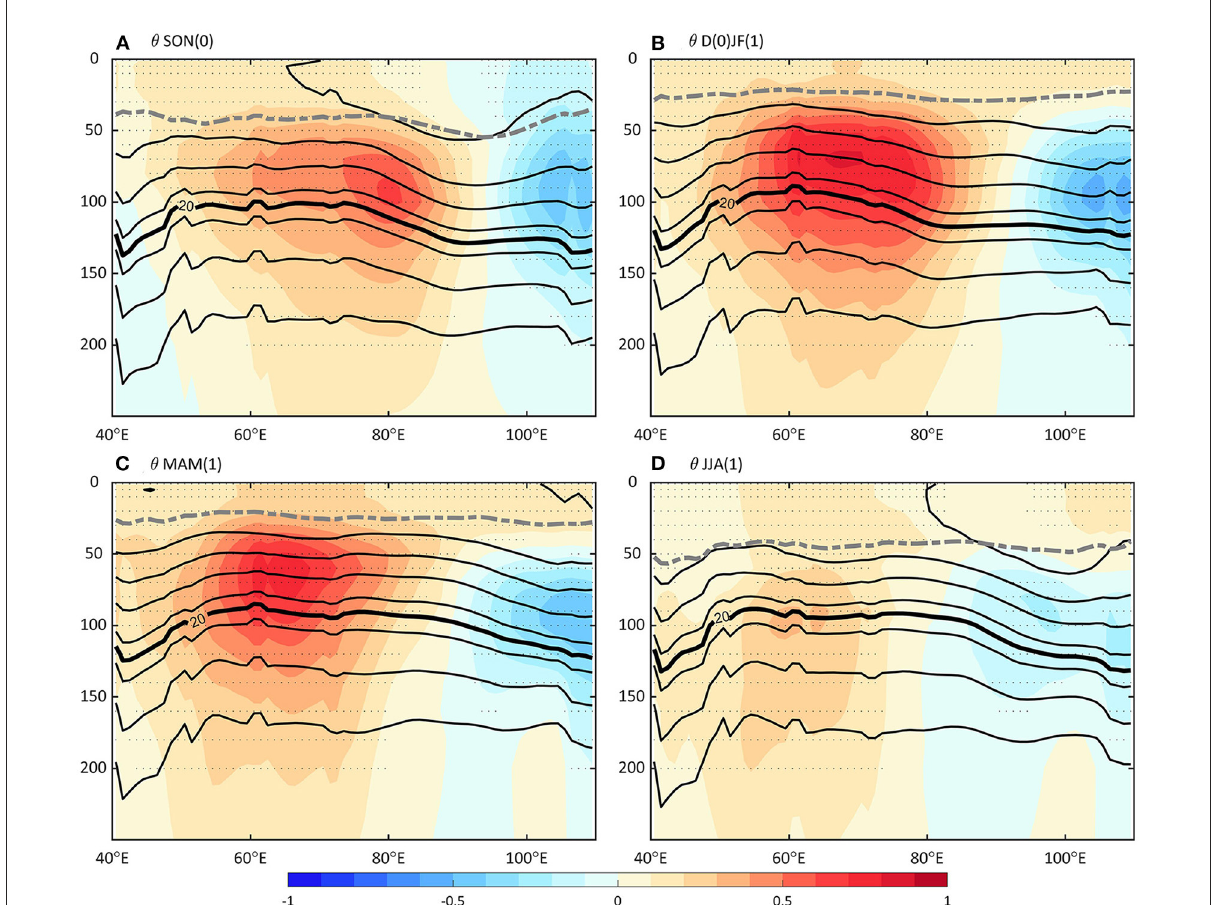
FIGURE4 Regression of IAP potential temperature anomalies (shading, ◦ C) averaged meridionally in 5S ◦ -15S ◦ in SON(0) (A) , D(0)JF(1) (B) , MAM(1) (C) , and JJA(1) (D) upon the NDJ Niño3.4 SST from 1982-2021. Solid back lines show the climatological mean potential temperature for every 2 ◦ C with a thickened 20 ◦ C line. Gray dashed line indicates the mixed-layer depth. Stippling indicates confidence level > 95% in students’ t- test. Linear trends and seasonal cycles are